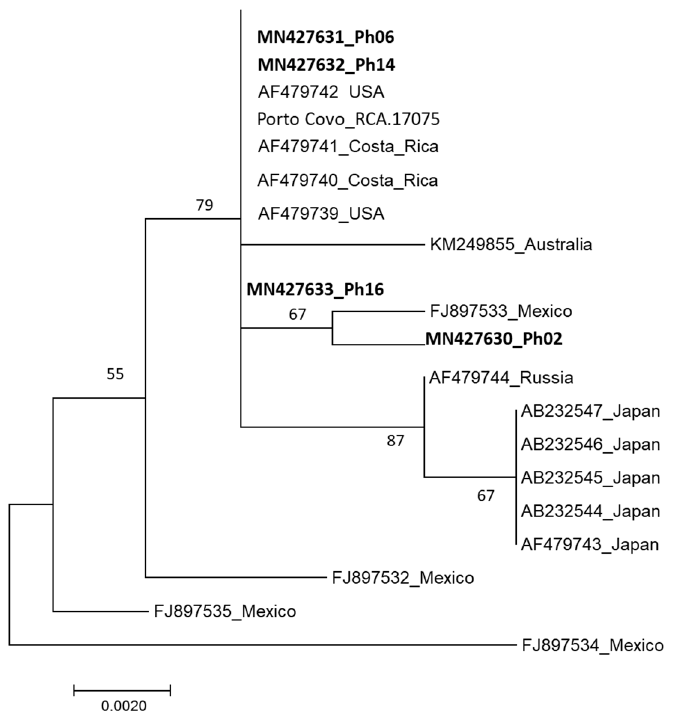
Figure 3. Maximum likelihood (ML) tree generated using rDNA-ITS region for the establishment of phylogenetic relationships between four Puccinia hemerocallidis isolates studied and the homologous sequences of isolates from Australia [25], Costa Rica [18], USA [18], Japan [26], Mexico [24], Portugal (Porto Covo; [17]) and Russia [18]. Bootstrap values above 50% are indicated above each branch. The isolates from this study are in bold font.